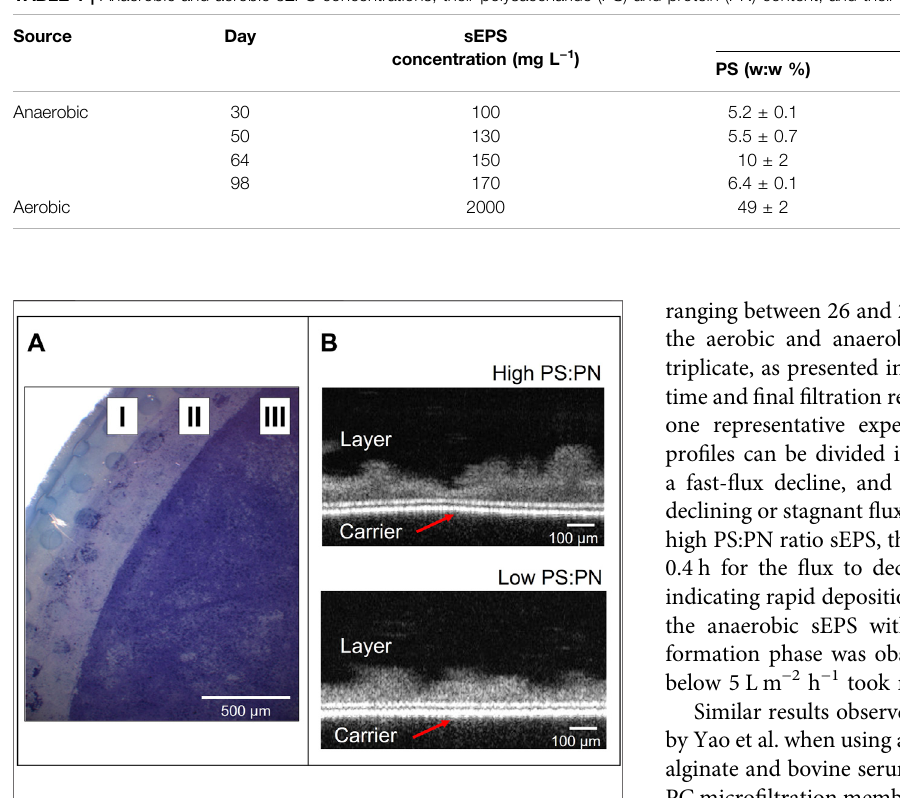
FIGURE2| sEPSgellayersafterthedead-end fi ltrationexperiments. (A) A bright fi eld stereomicroscopy image of low PS:PN sEPS layer stained with crystal violet on the top of the polycarbonate carrier. Zone I and II are the carrier zones covered with a rubber o-ring; zone III is where the sEPS layer formed. (B) Static OCT images of the layers formed with sEPS with high (upper image, from the aerobic reactor) and low (lower image, from the anaerobic reactor) PS:PN